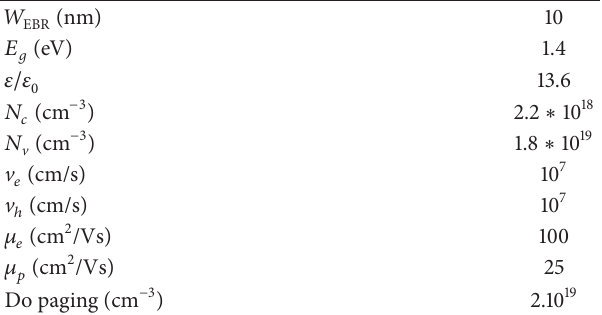
Table 3: Properties of the EBR layer used in our